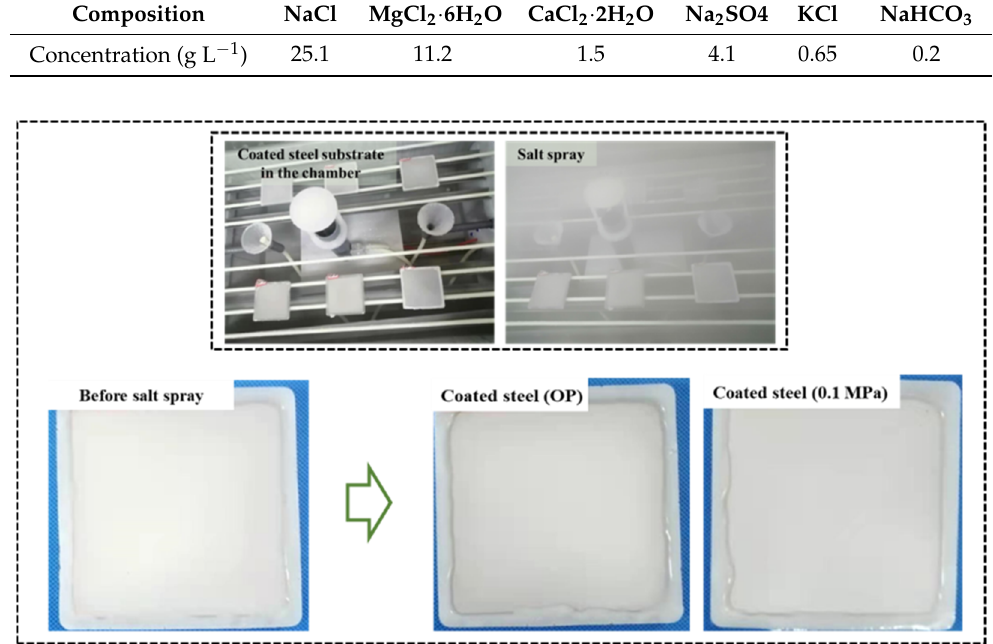
Figure 9. The pull strength of the coating after UV radiation with different duration. Table 4. Concentrations of inorganic salts in artificial seawater. Table 4. Concentrations of inorganic salts in artificial seawater.